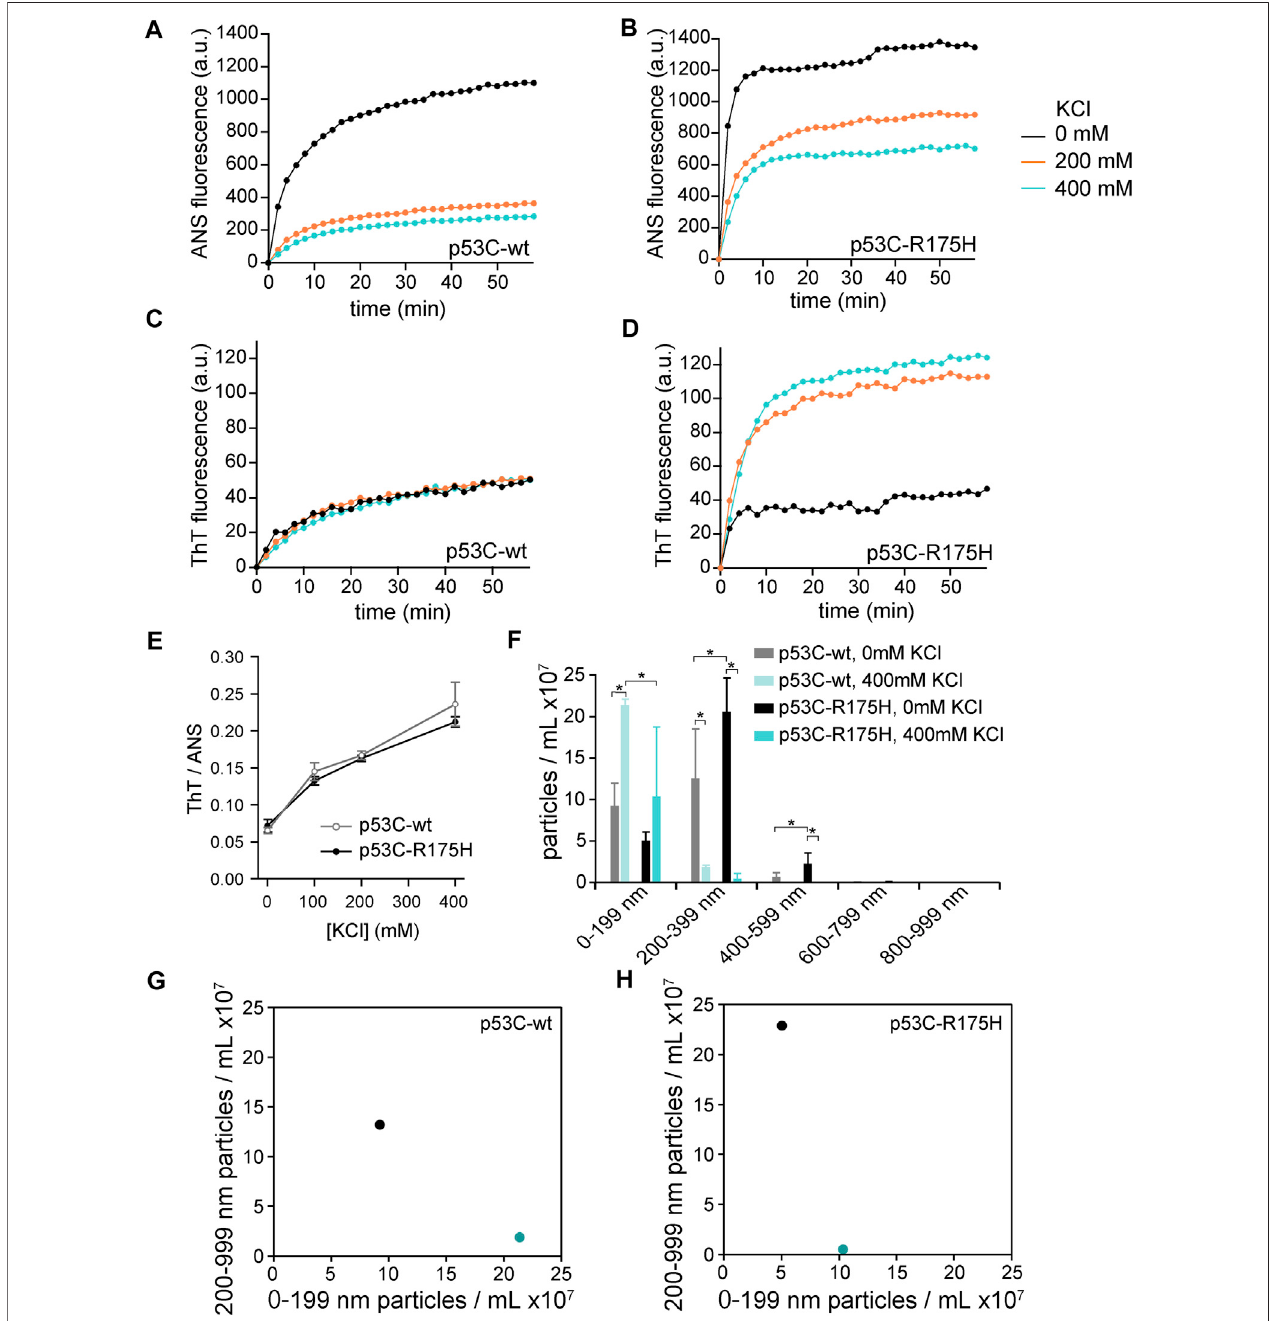
FIGURE 1 | (A – D) Effect of KCl on aggregation of p53C-wt and p53C-R175H. p53C solution was aggregated at 37 ° C in the absence of KCl (black), with 200 mM KCl (orange), or with 400 mM KCl (cyan), and the values were plotted every 2 min. (A) ANS fl uorescence in p53C-wt; (B) ANS fl uorescence in p53C-R175H; (C) ThT fl uorescenceinp53C-wt;and (D) ThT fl uorescenceinp53C-R175H. (E) TheratioofThTtoANSofp53C-wt(gray,opencircle)andp53C-R175H(black,solidcircle)were plotted against the concentration of KCl. (F) Results of NTA. The size of the aggregates of p53C-wt and p53C-R175H formed in the absence of KCl or in 400 mM KClwasdividedinto200 nmincrements. (G,H) Thenumberofparticlesinthesizerange0 – 199 nmisplottedonthehorizontalaxisandthenumberofparticlesinthesize range200 – 999 nmontheverticalaxisforp53C-wt (G) andp53C-R175H (H) ,respectively.ThedataareidenticaltothoseinPanel (F) .BlackisintheabsenceofKCl,and cyan is under 400 mM ( Figure 1D ). There was concern that these fl uorescence either p53C-wt or p53C-R175H. For ANS fl uorescence, fl uctuations were due to the ionic effect of 400 mM KCl. approximately 180% and 140% fl uorescence enhancement Thus, we examined the effect of KCl in the presence of were observed against non-aggregated p53C-wt and p53C-